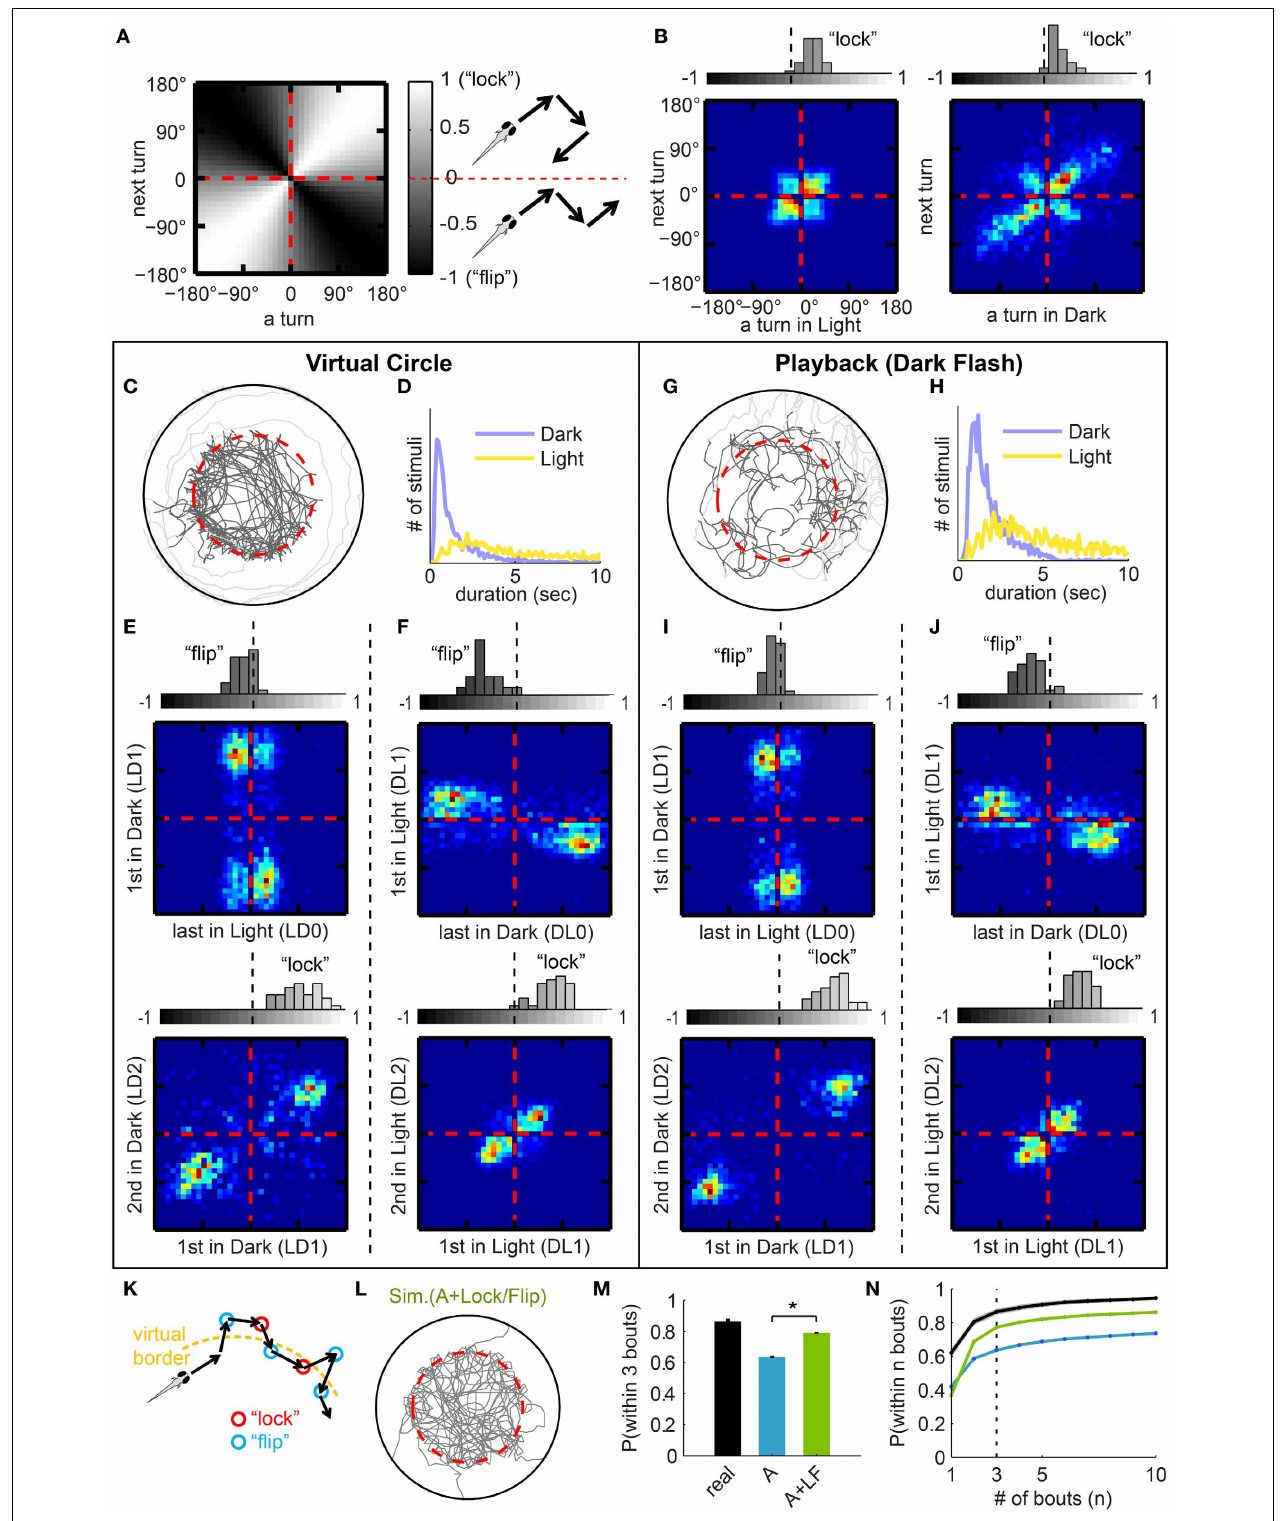
FIGURE 3 | Turning modulation around light transitions. (A) Value map of “lock-index” for correlation matrices (B,E,F,I,J) . For a pair of consecutive turns, “locked” turns (2 turns in the same direction) populate the white